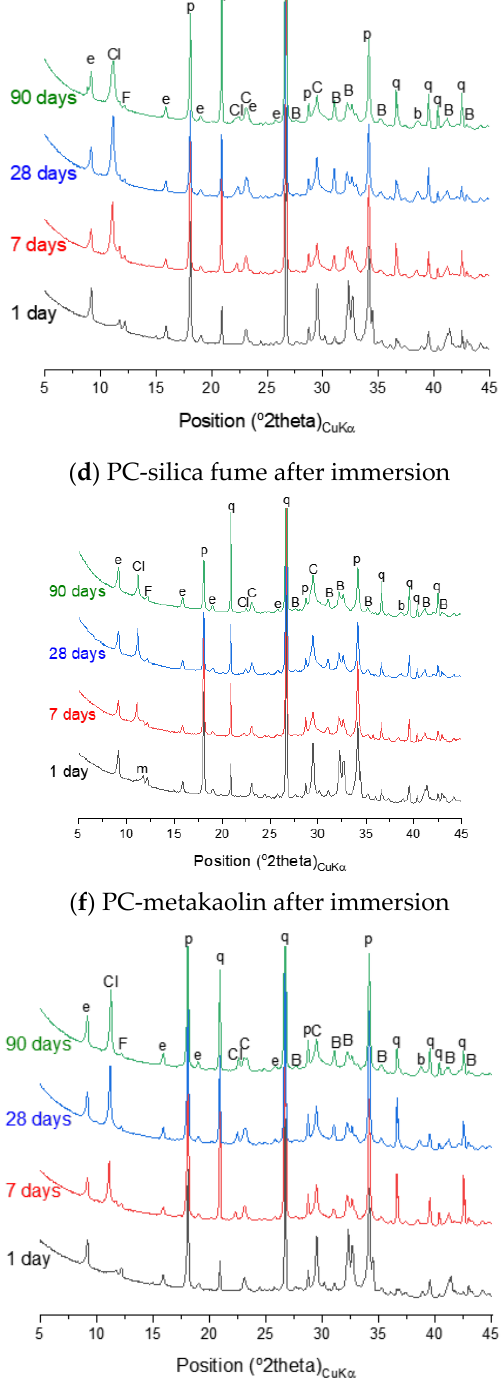
Figure 8. X-ray diffraction (XRD) patterns of neat PC and PC blended with silica fume, metakaolin or glass powder during hydration and after immersion in seawater up to 90 days. The following symbols are used to denote: B — belite, C — calcite, F — ferrite, q — quartz, b — brucite, e — ettringite, h — hemicarbonate, m — monocarbonate, p — portlandite, Cl — hydrocalu- mite.